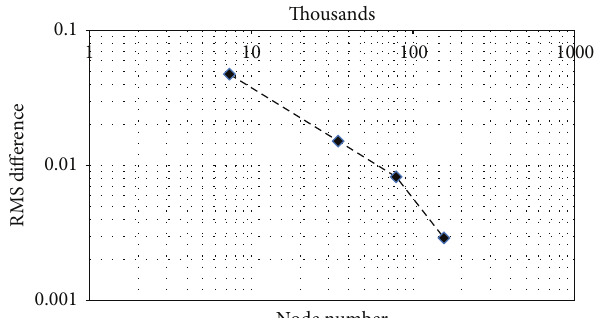
Figure 7: Mesh independence study.